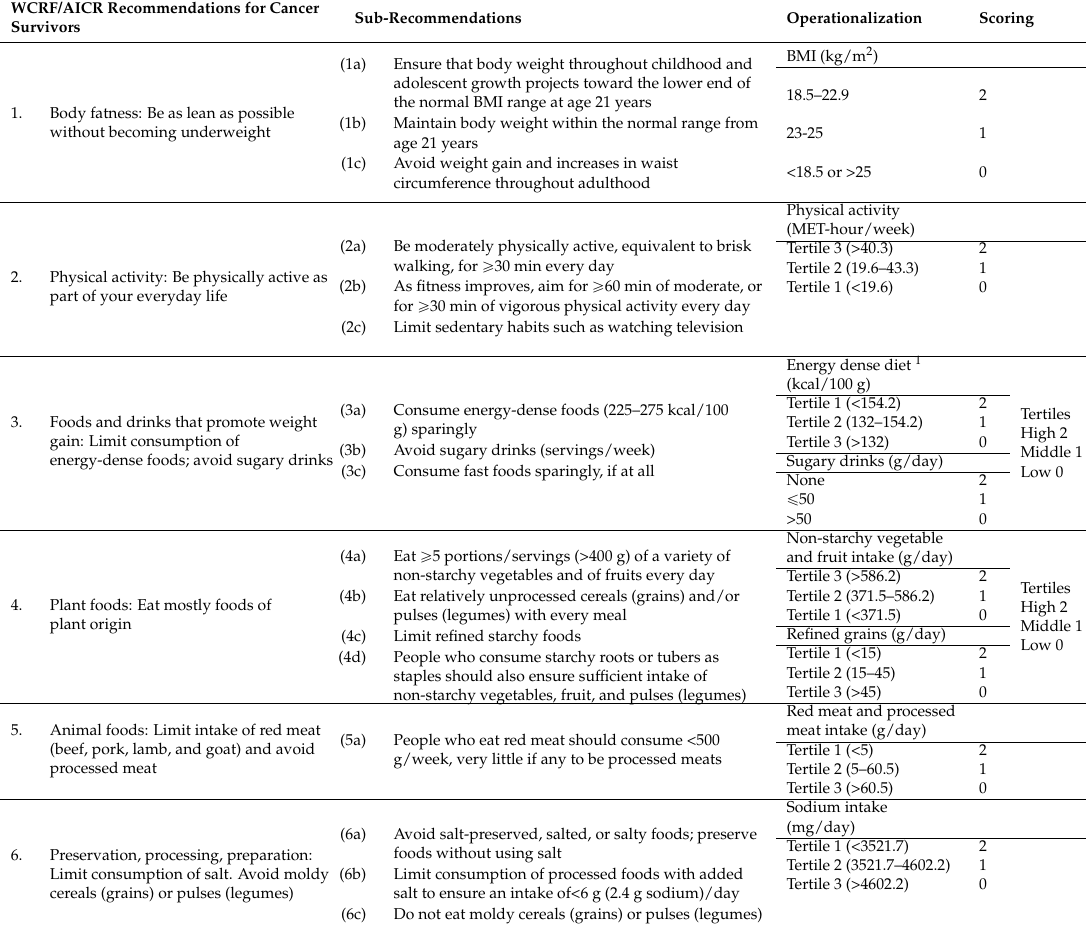
Table 2. Operationalization of adherence to WCRF/AICR